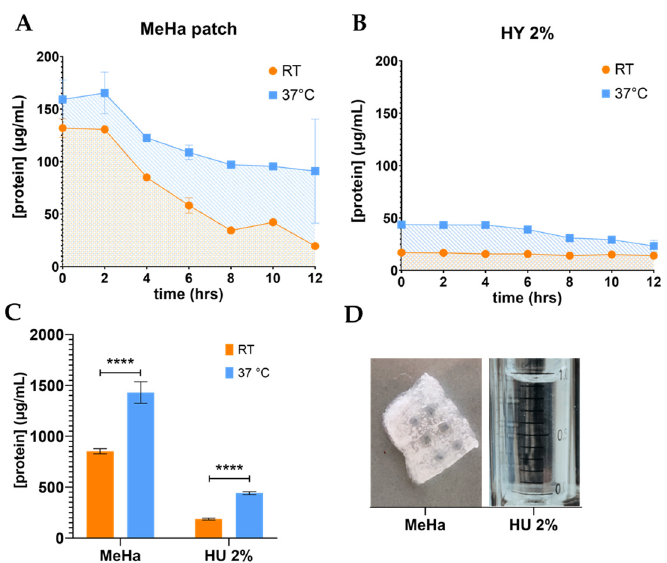
Figure 2. ( A , B ) Release curve of ADNVs from hyaluronic-acid-based materials, MeHA patch and HY 2% gel, at room temperature (RT = 25 °C) and physiological temperature (37 °C). ADNV release is expressed in form of protein concentration ( μ g/mL) in time (hours). ( C ) Values corresponding to the area underneath each curve in ( A , B ) (SE). ( D ) Illustrative image of MeHA patch and HY 2% gel. **** p < 0.0001.